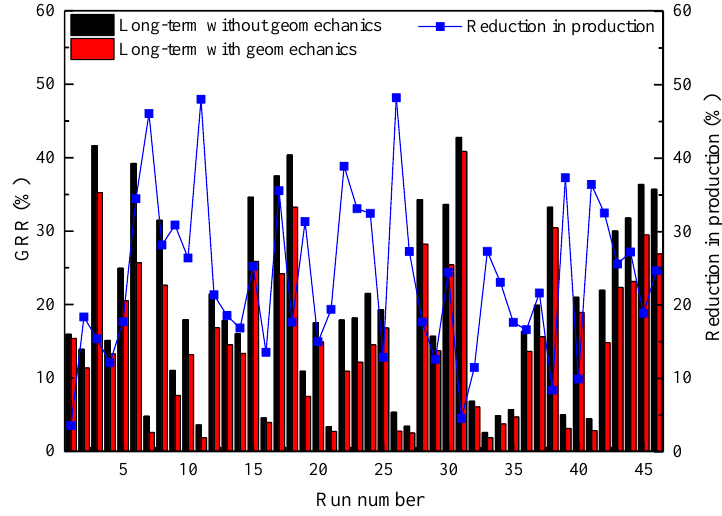
Figure 5. Gas recovery rates of 46 simulation cases without/with geomechanics.